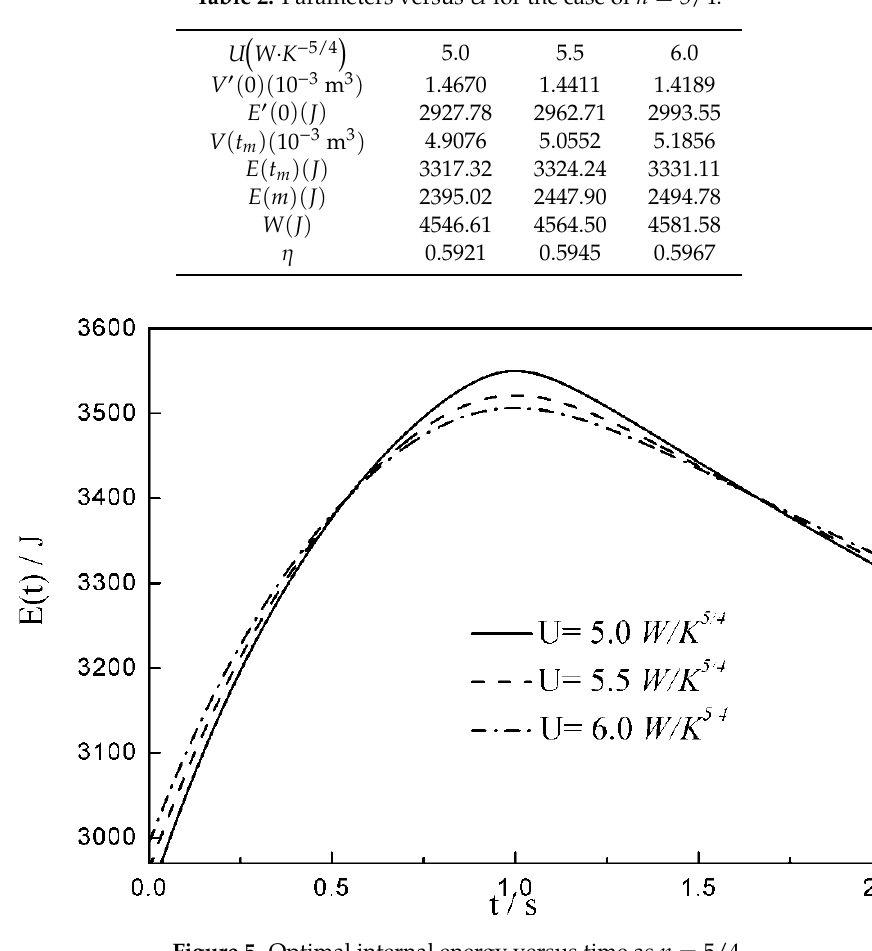
Figure 5. Optimal internal energy versus time as n = 5/4.